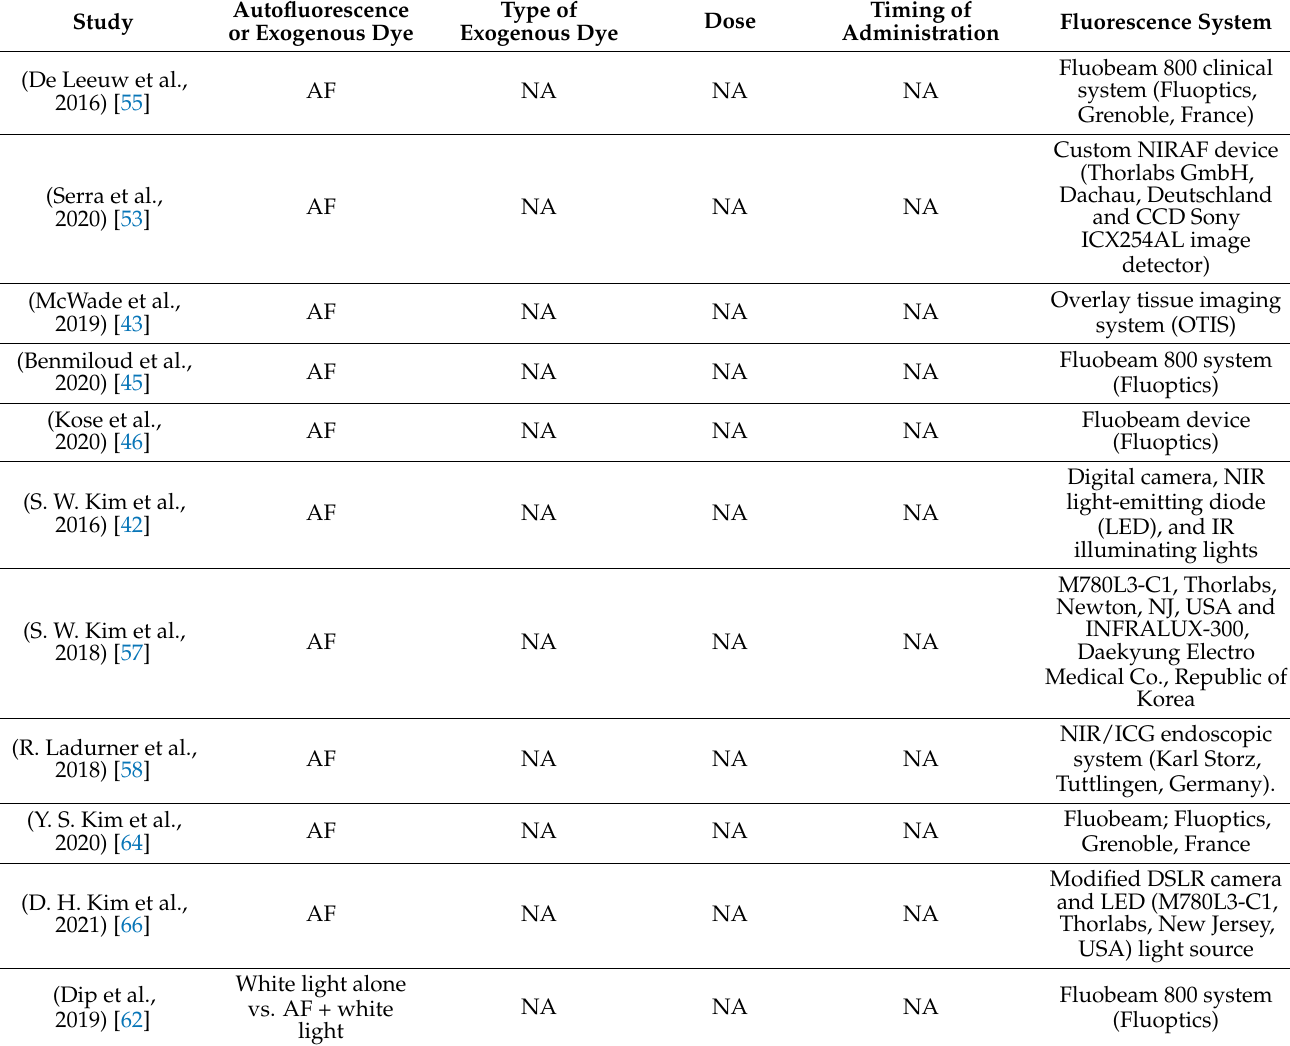
Figure 2. A sequence of images showing ICGA of two PGs (arrows) from A to C. ( A ) Autofluorescence of the PG before the injection of ICG. ( B , C ) Diffusion of the ICG contrast agent confirming a well-vascularized PG (Fluobeam LX ® —Fluoptics©, Grenoble, France). Table 3. Fluorescence type, dosage, timing, and fluorescence system.